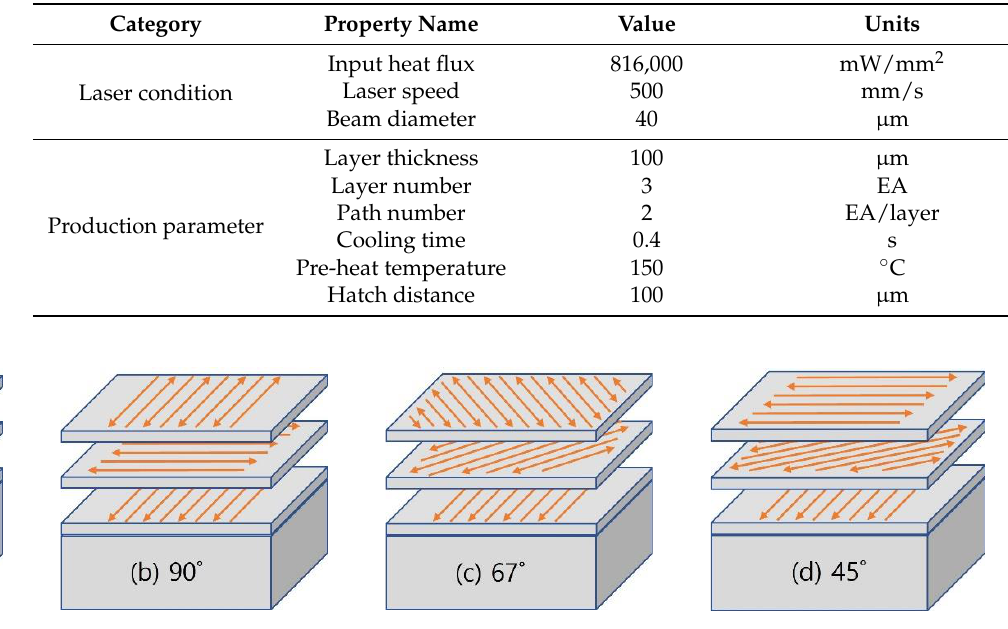
( c ) Figure 4. Laser heat input simulation result: ( a ) 68 ms — early stage of first layer heat input; ( b ) 1121 ms — second layer heat input; ( c ) 1904 ms — third layer heat input. To examine the effect of the lower layer due to the heat input of the upper layer, the temperature and residual stress changes were confirmed. As the heat source propagated, the temperature changed in the six points at the center of the first layer shown in Figure 2. The results are illustrated in Figure 5, and the resulting residual stress changes are